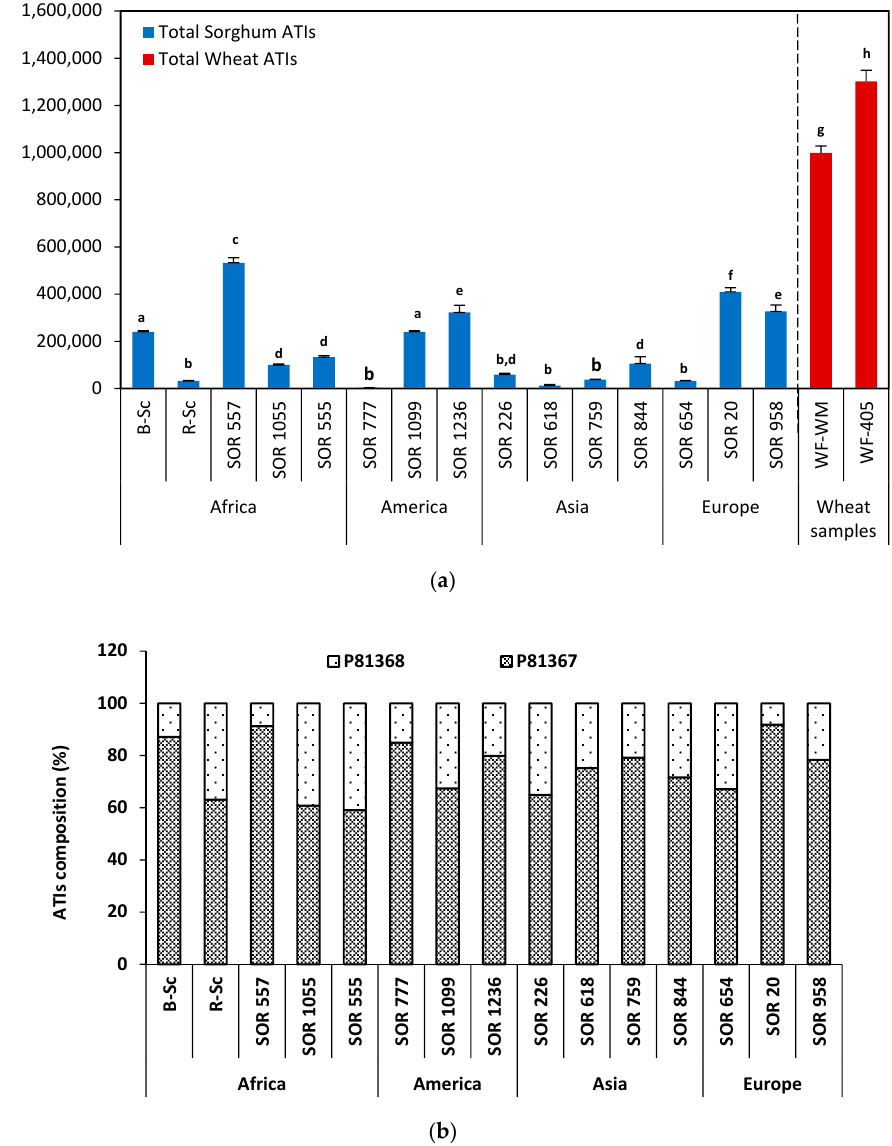
Figure 4. Comparison of ( a ) relative ATIs content of sorghum samples expressed in peak area / mg flour and ( b ) proteins P81367 and P81368 distribution. Data are expressed as means ± standard deviation, n = 3. Di ff erent letters indicate significantly di ff erent values ( p <